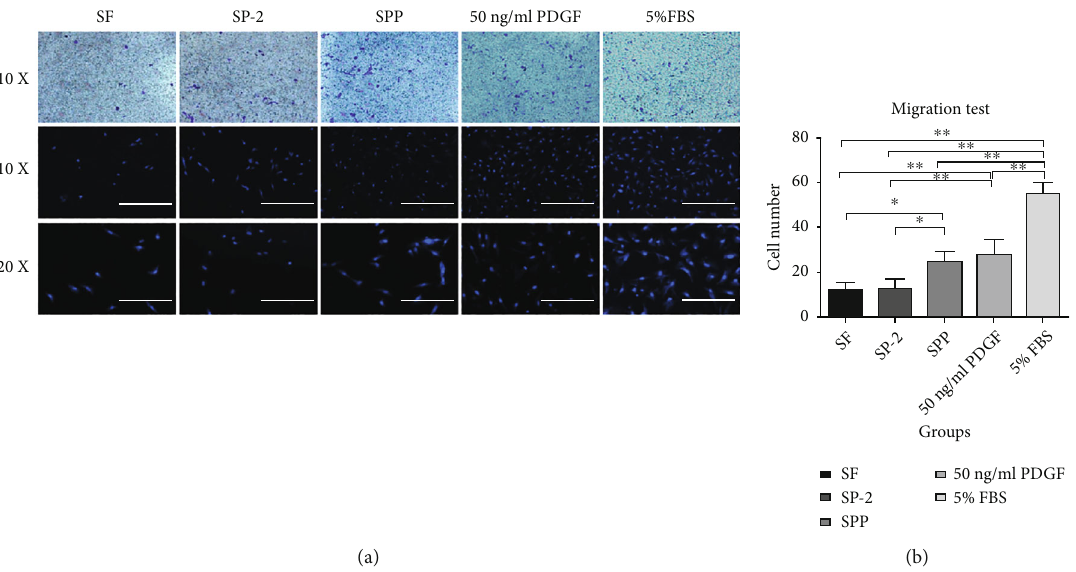
Figure 5: Transwell migration assay of the e ff ects of PDGF released from the sca ff olds on SMSCs migration. (a) Microscopic images of crystal violet and fl uorescent staining of cells cultured in media that contained control or sca ff old loaded with PDGF after 24 h of culture. (b) Quantitative comparison of migrated cells among the di ff erent groups, ∗ P < 0 : 05 and ∗∗ P < 0 : 01 compared with control.